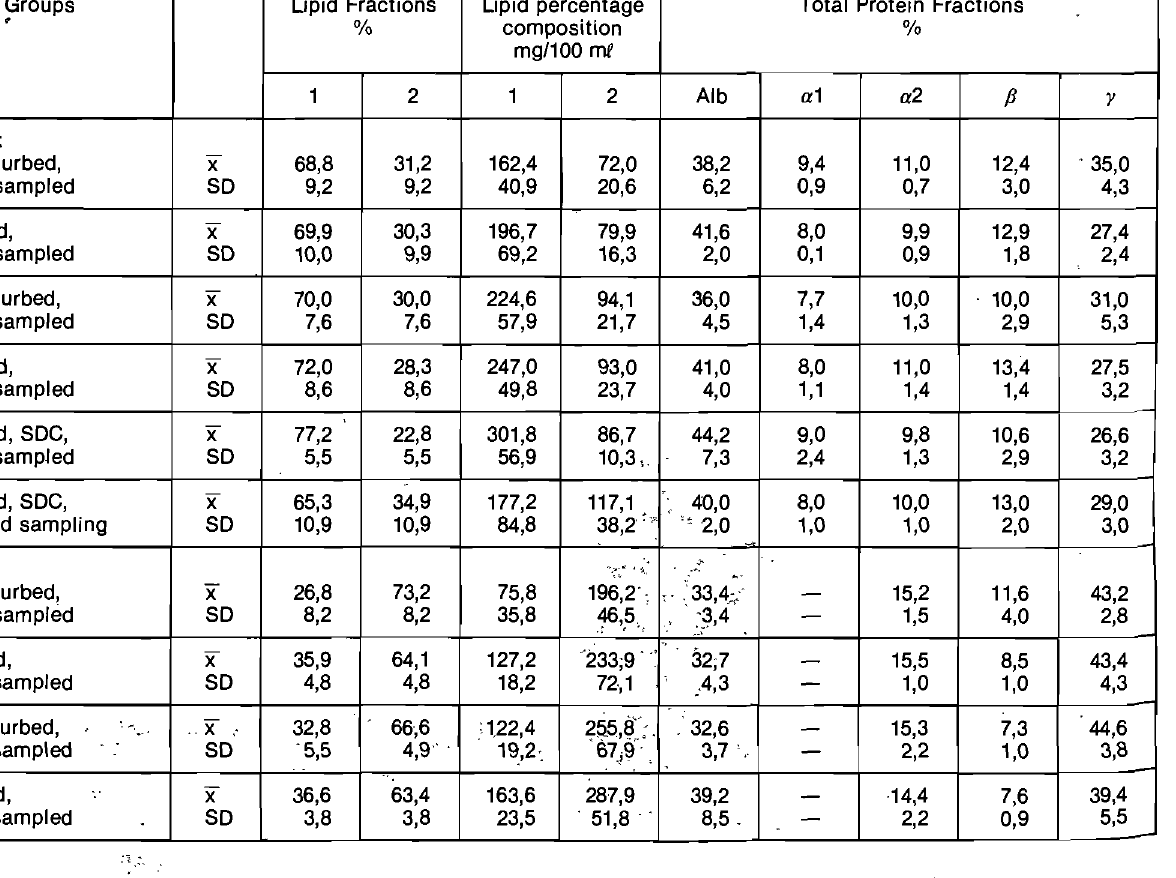
Table 4: LIPID FRACTIONS, PERCENTAGE COMPOSITION AND PROTEIN FRACTIONS OF THE DIFFERENT GROUPS